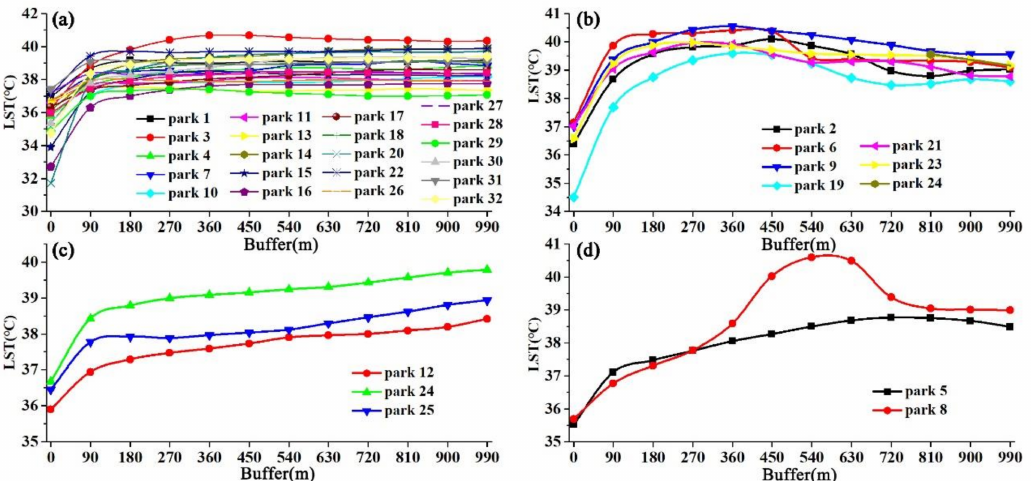
Figure 7. Variation of surrounding LSTs from the urban park boundary: ( a ) regular parks, ( b ) decreased parks, ( c ) increased parks, and ( d ) other